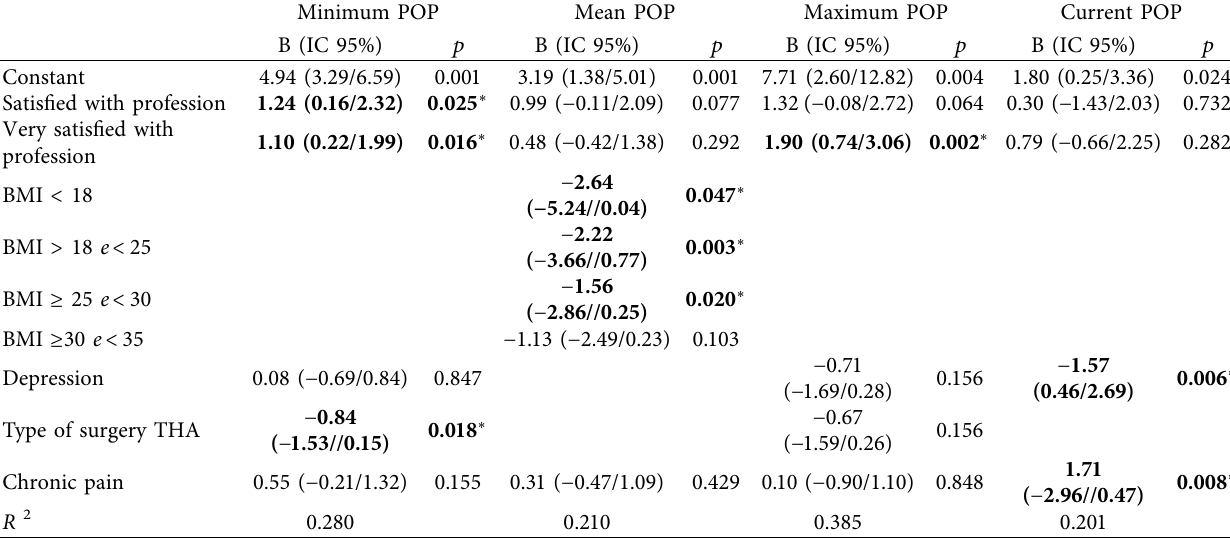
Table 4: Multiple linear regression analysis of postoperative pain ( n �